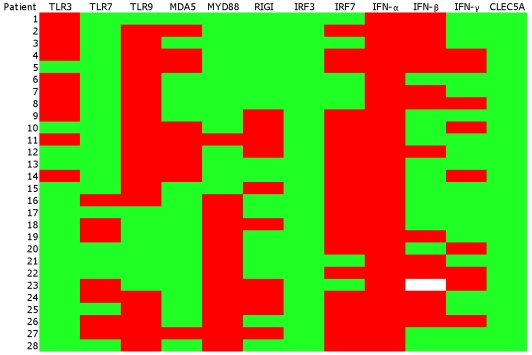
Heatmap for gene expression data of the 12 genes (columns) studied from the 28 patients (rows).The first 15 are DF patients, while the rest are DHF patients. The DF/ND and DHF/ND gene expression values from qPCR were used to create the heatmap. The colour shades are associated with the values in the cells: green for ratio of DF/ND and DHF/ND of <1 (down-regulated) and red for DF/ND and DHF/ND ratio of > = 1 (up-regulated). The gene expression data for IFN-β of one of the patients (23) was not available and therefore the vector attributes of this gene for the patient were represented as blank.